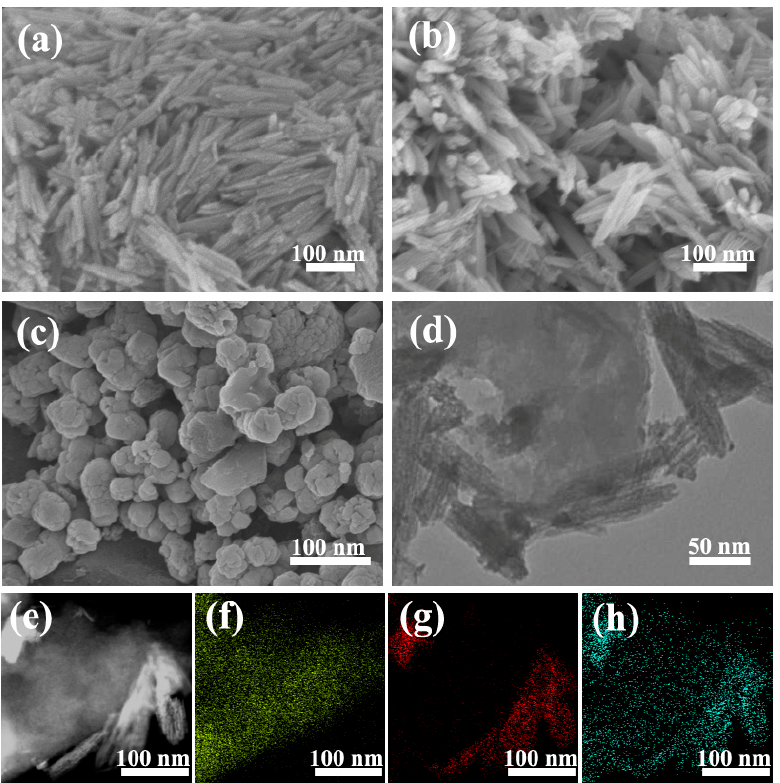
Figure 2. SEM images of Fe 2 O 3 ( a ), FPC-90 ( b ), FPC-180 ( c ), and TEM images of FPC-90 ( d , e ) com- posites with corresponding elemental mapping images of C ( f ), Fe ( g ), and O ( h